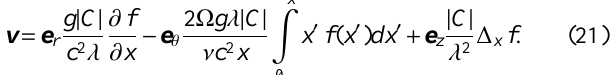
Figure 2. The best approximation of dimensionless poloidal veloc- ity profile f ( x ). The values of the parameters A and a 2 in the Taylor expansion (20) correspond to the position of the peak in Fig. 1.